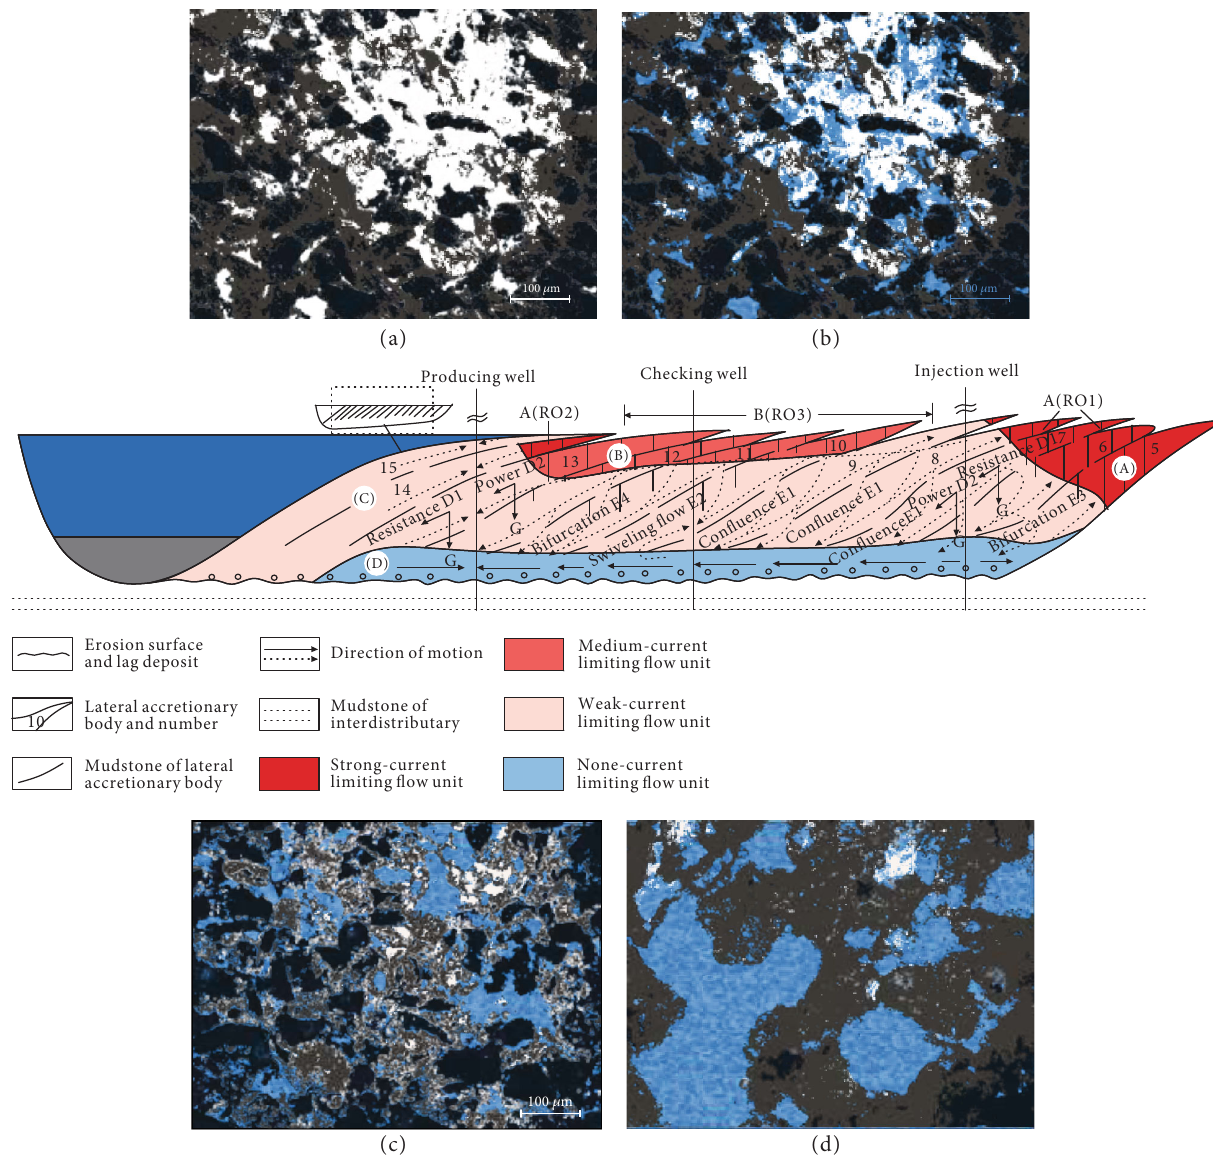
Figure 19: Microscopic remnant oil model of the point bar sand body fl ow units. White areas represent microscopic remnant oil, black to gray areas represent mineral particles; and blue areas represent foggy-shaped remnant oil. (a) Strong-current limiting fl ow unit microscopic remnant oil model. (b) Medium-current limiting fl ow unit microscopic remnant oil model. (c) Weak-current limiting fl ow unit microscopic remnant oil model. (d) None-current limiting fl ow unit microscopic remnant oil